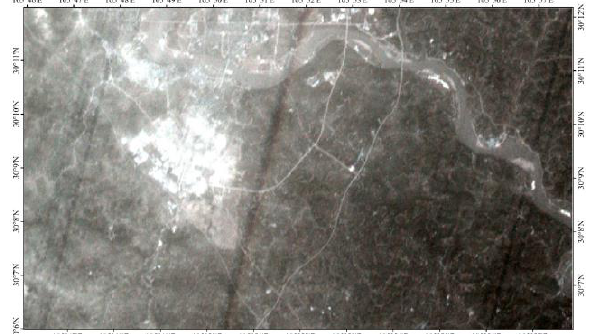
Figure 4. The experimental HSI data of ZY-1 02D AHSI.